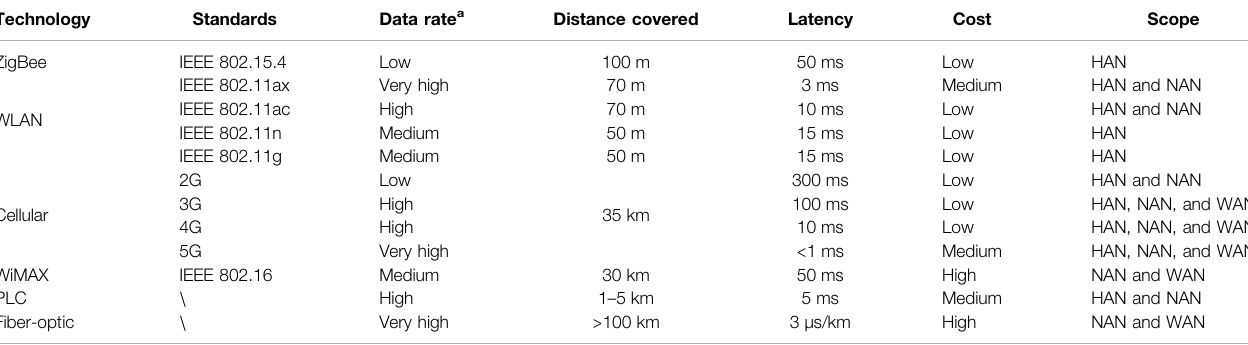
TABLE 1 | Comparison of typical communication technologies for a smart grid.